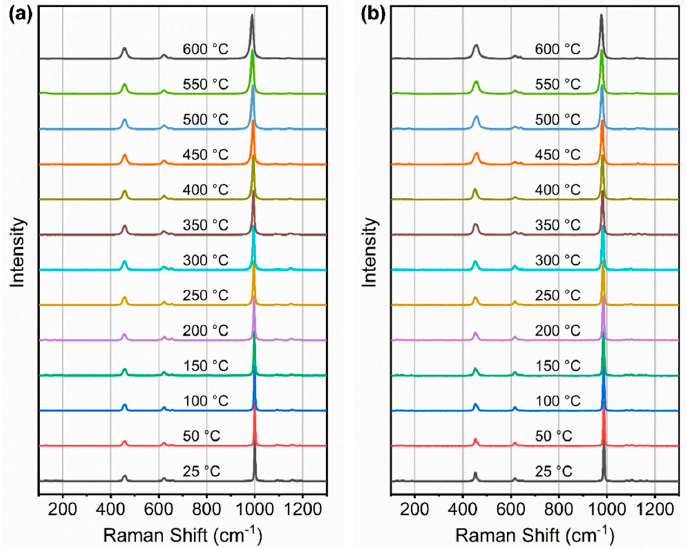
Figure 5. Raman spectra at atmospheric pressure of ( a ) celestine and ( b ) barite as functions of temperature (figures adapted from [8]; see reference for details).